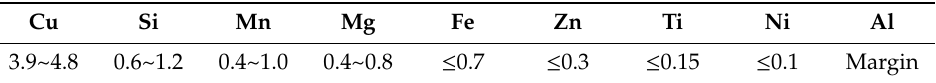
Table 3. Chemical composition of 2A14 Aluminum Alloys.